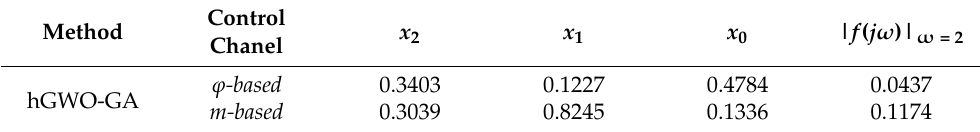
Table 12. Parameters of robust SSSC-based stabilizer of IEEE 50-Machine Power System.